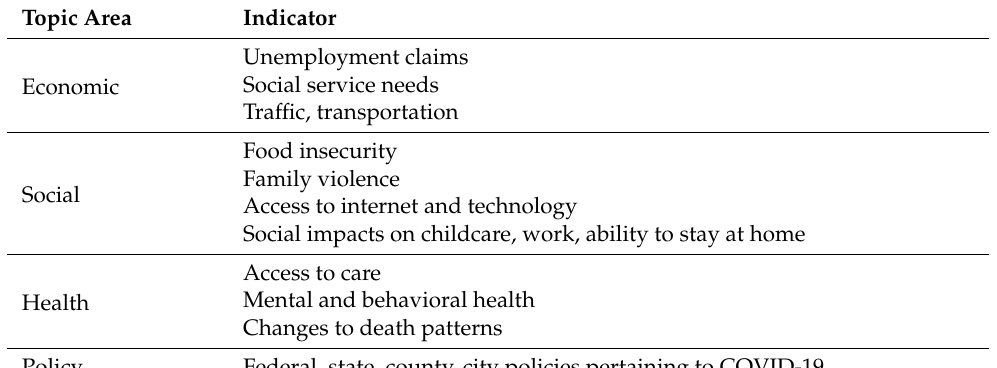
Table 1. PHSKC framework for social, economic, and overall health outcomes.